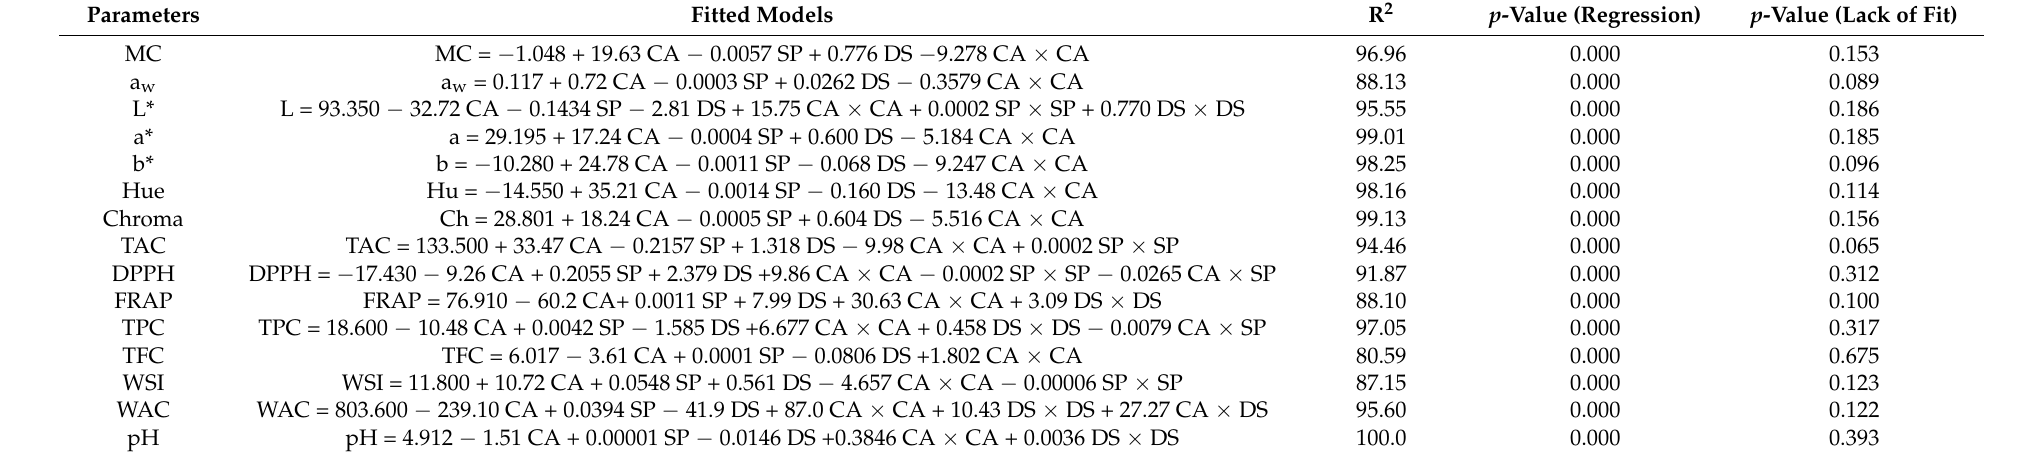
Table 3. Adequacy of the models fitted for the purple sweet potato